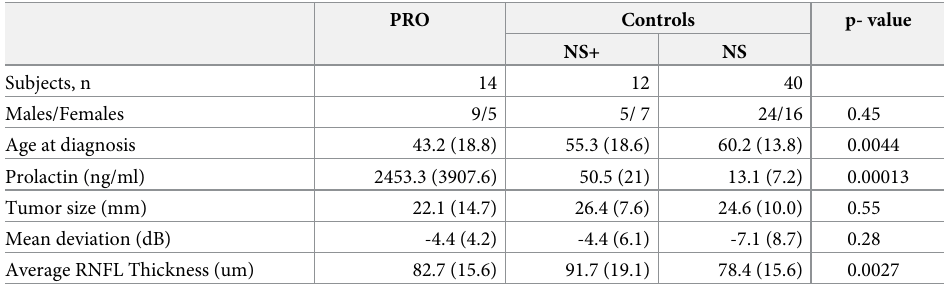
Table 3. Subject characteristics by group including visual ability as mean deviation recorded by Humphrey 24–2 automated perimetry (PRO n eyes = 22, controls NS+ n eyes = 18, controls NS n eyes = 33) and SD-OCT